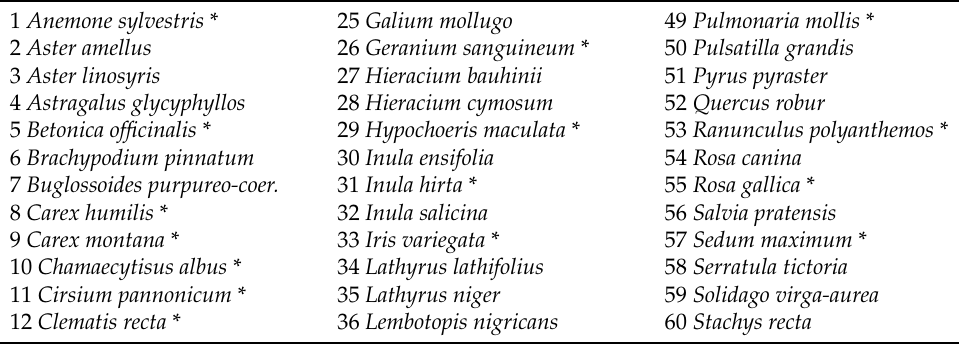
Table 1. List of forest steppe species of the investigated abandoned lands (*—FS species determined by Schmotzer